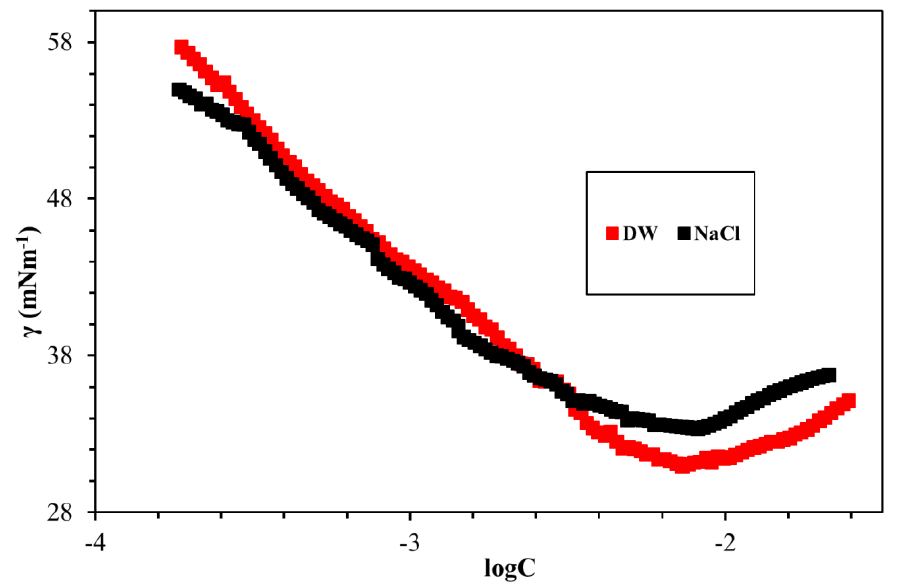
Figure 10. Comparison of surface tension of TEAC DW and in 1M NaCl at 30 °C.